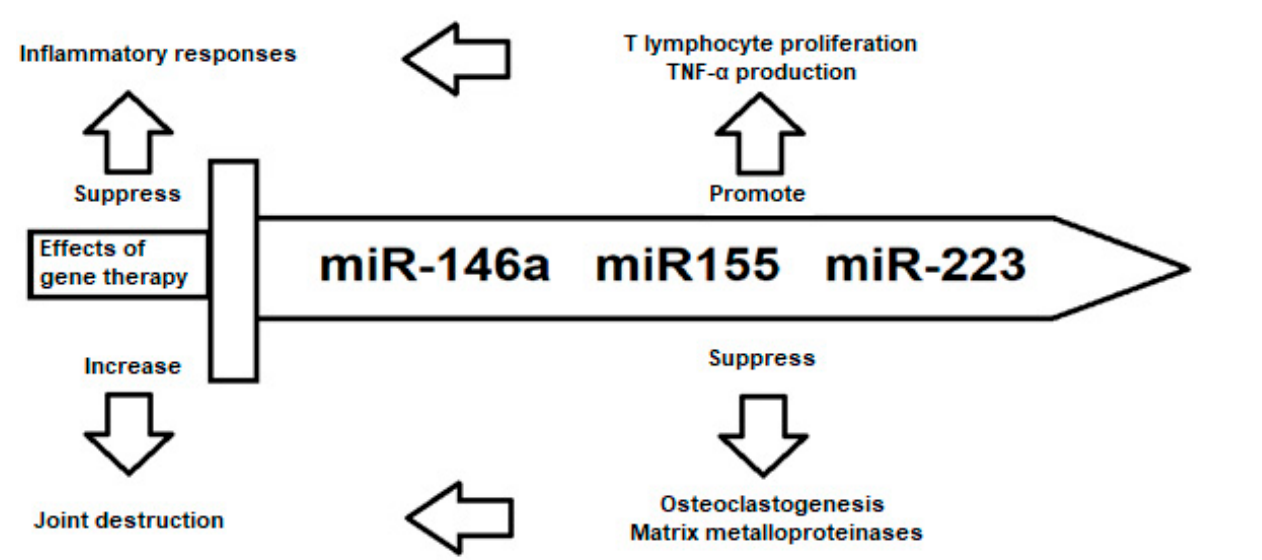
Figure 3. “Double-edged sword”: Opposing roles of miR-146a, miR-155 and miR-223 in the regulation of rheumatoid arthritis (RA) pathogenesis. These miRNAs are positively correlated with disease activation by instigating the inflammatory response. However, at the same time, they have a role in suppressing joint destruction.